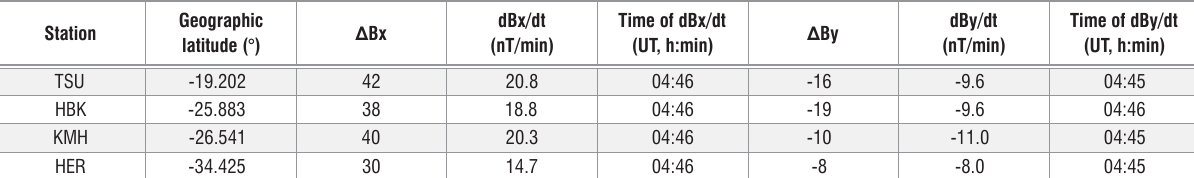
The sudden magnetic field increase in B from 04:45 to 04:47 UT on 17 March 2015 at four magnetic observatories: HER, HBK, TSU and KMH Station